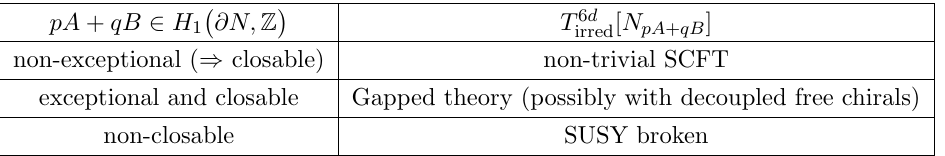
Table 4 . Basic property of T 6 d [ N pA + qB ]. A primitive boundary cycle pA + qB is called exceptional irred if N pA + qB is